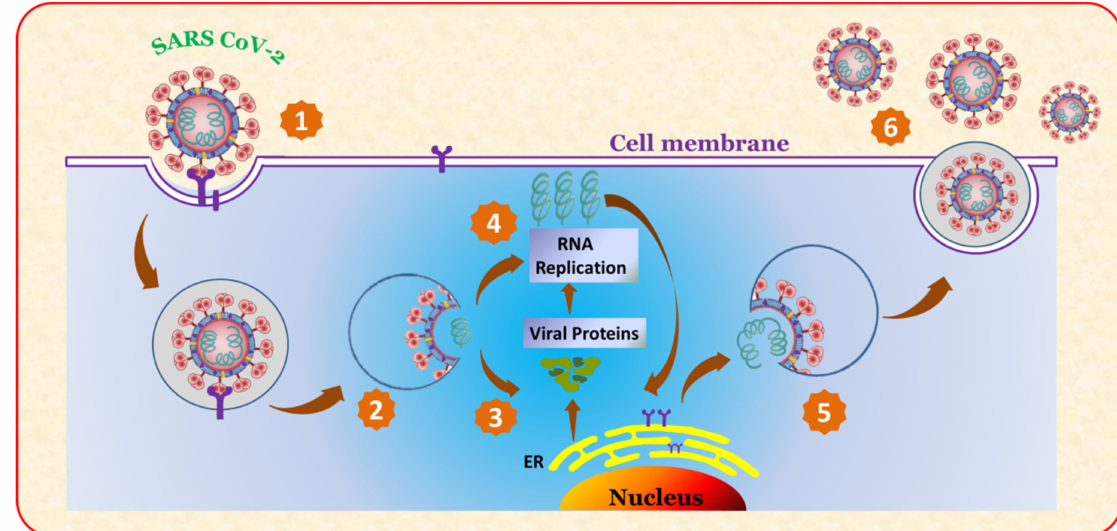
Figure 1. Principle of Multiplication of SARS-CoV-2